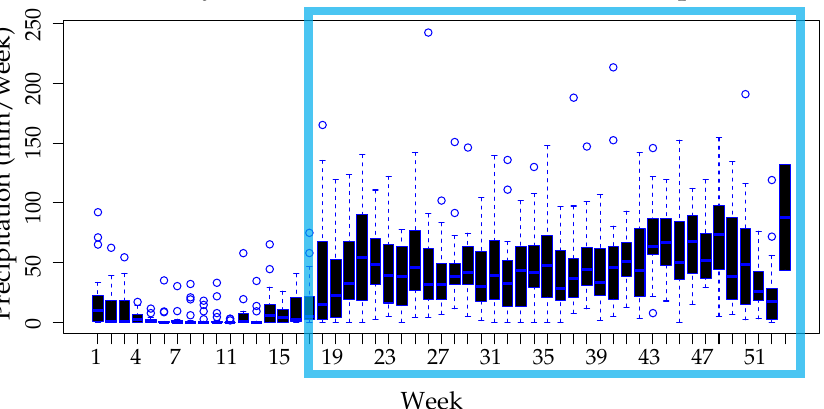
Figure 9. Weekly distribution of accumulated Precipitation, grouped by week along the study period.